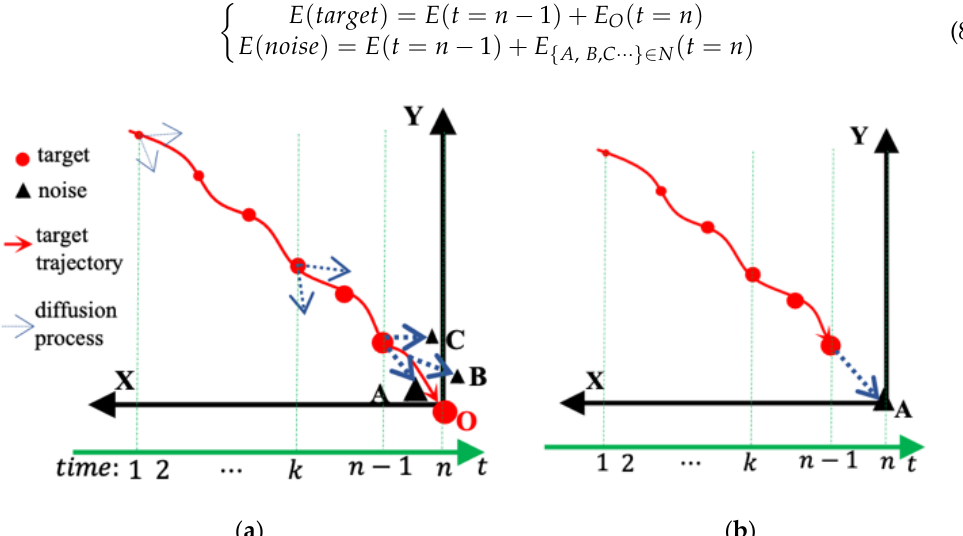
Figure 2. Target energy accumulation and diffusion in the DP process. ( a ) Energy accumulation and diffusion process of target; ( b ) Diffusion effect for noise.